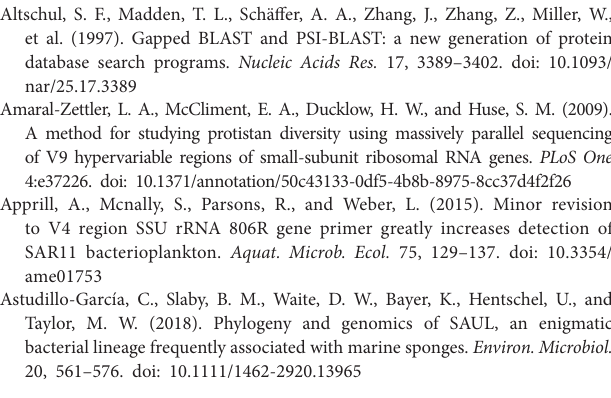
Supplementary Table S12 | Fungal taxonomic composition of OTUs obtained exclusively in Aplysina caissara (A) , Aplysina fulva (B) , Tedania ignis (C) , seawater (D) , sediment (E) , and the core of all categories (F) . Supplementary Table S13 | List of enriched features provided by linear discriminant analysis (LDA) of effect size (LEfSe) that are differential across sponge species, seawater, and sediment with statistical and biological significance, and ranked according to the effect size (LDA) for the whole fungal community. Supplementary Table S14 | OTUs vs. samples table containing all categories and OTU taxonomic assignments for the unicellular eukaryotic dataset. Supplementary Table S15 | Relative abundance of the unicellular eukaryotic composition for phylum (A) and class (B) . Ac: Aplysina caissara , Af: Aplysina fulva , Ti: Tedania ignis , SW: seawater, SD: sediment. Supplementary Table S16 | Results from BLASTn of the unicellular eukaryotic unclassified OTUs associated with sponge species (A) and summary of taxonomic distribution of the unclassified OTUs (B) are shown. Ac: Aplysina caissara , Af: Aplysina fulva , Ti: Tedania ignis , SW: seawater, SD: sediment. Supplementary Table S17 | Unicellular eukaryotic taxonomic composition of OTUs obtained exclusively in A. caissara (A) , Aplysina fulva (B) , Aplysina ignis (C) , sponge core (D) , seawater (E) , and sediment (F) . Supplementary Table S18 | List of enriched features provided by linear discriminant analysis (LDA) of effect size LEfSe that are differential across sponge species, seawater, and sediment with statistical and biological significance, and ranked according to the effect size (LDA) for the whole the unicellular eukaryotic group. Supplementary Table S19 | OTUs vs. samples table containing all categories and OTU taxonomic assignments for fungal dataset. Supplementary Table S20 | Fungal community composition of the habitat generalist group (A) and habitat specialist group (B) . Ac: Aplysina caissara , Af: Aplysina fulva , SW: seawater, SD: sediment. Supplementary Table S21 | Values for richness, diversity, and evenness indices. Ac: Aplysina caissara , Af: Aplysina fulva , Ti: Tedania ignis , SW: seawater, SD: sediment. Supplementary Table S22 | Statistical analyses of the alpha ecological metrics for the fungal dataset (A) and for the unicellular eukaryotic dataset (B) . Ac: A. caissara , Af: Aplysina fulva , Ti: Tedania ignis , SW: seawater, SD: sediment. Supplementary Table S23 | Permutational multivariate analysis of variance (PERMANOVA) and analysis of similarity (ANOSIM) of whole, habitat generalist, and specialist groups of fungi and unicellular eukaryotic. Supplementary Table S24 | Relative abundance of the fungal composition for phylum (A) and class (B) . Ac: Aplysina caissara , Af: Aplysina fulva , SW: seawater, SD: sediment.